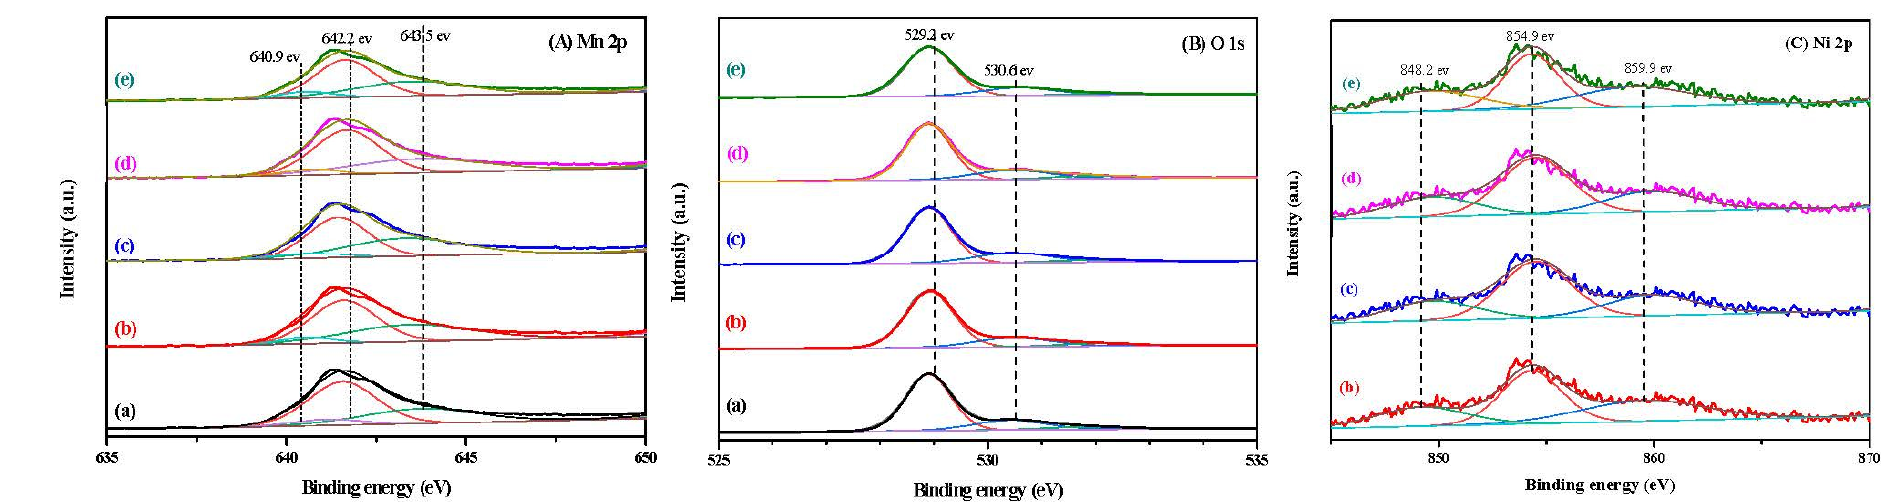
Figure 6. ( A ) Mn 2p, ( B ) O 1s, and ( C ) Ni 2p XPS spectra of ( a ) OMS-2, ( b ) 1Ni/OMS-2, ( c ) 3Ni/OMS-2, ( d ) 5Ni/OMS-2, and ( e ) 10Ni/OMS-2.